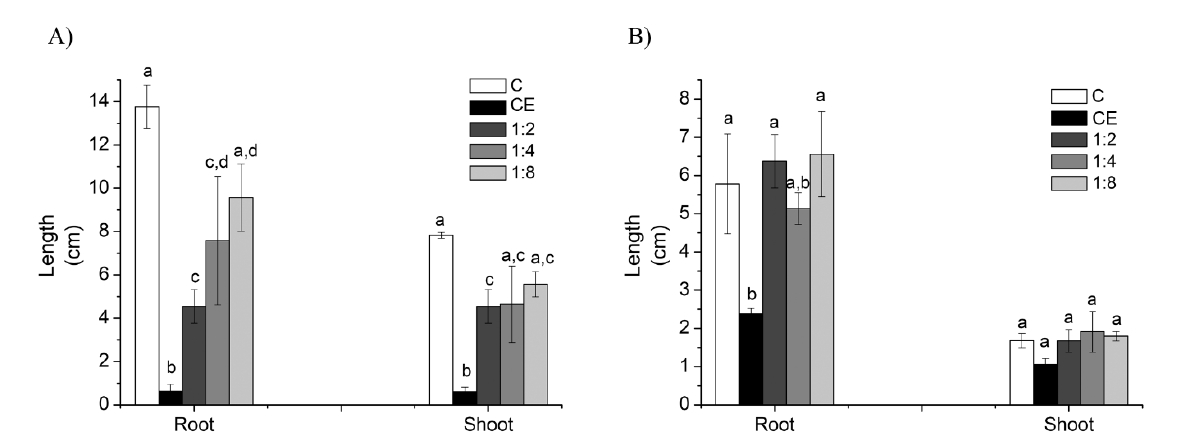
Figure 4. Influence of different concentrations of walnut leaf aqueous extract on root length and seedlings height in wheat (A) and pea (B). Different lower case letters a, b, c, d indicate a statistically significant difference of the measured parameter between treatments of one examined species (p